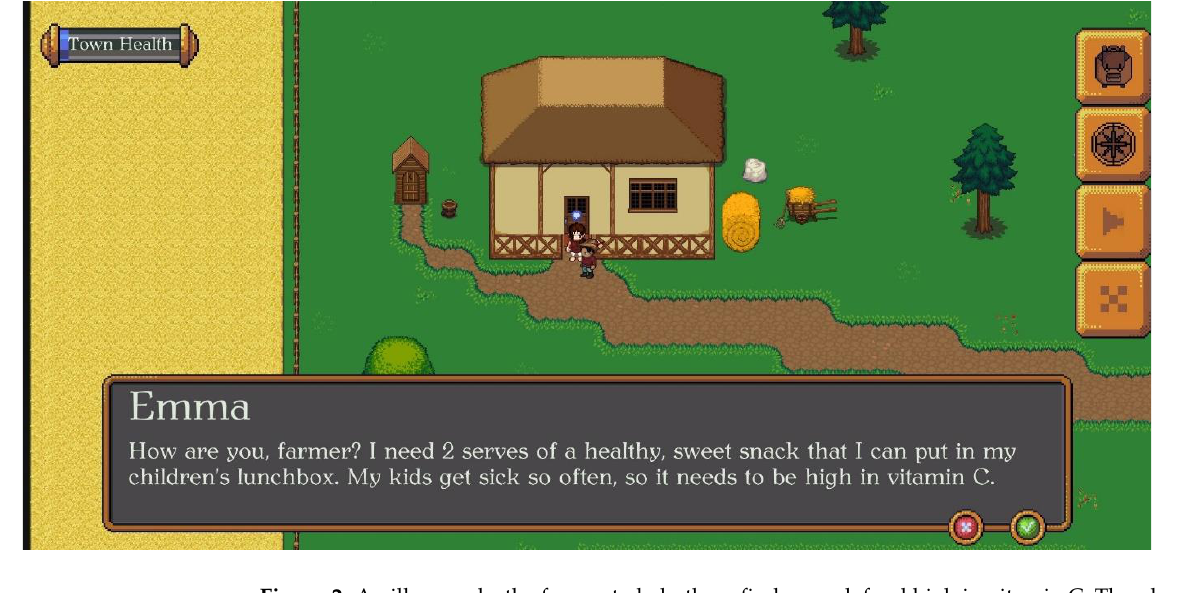
Figure 2. A villager asks the farmer to help them find a snack food high in vitamin C. The player will have to visit the village’s grocery shop. The village shop’s inventory is sorted by vitamins, minerals and dietary fibre. After clicking on a nutrient, a list of associated foods with basic information appears (e.g., Vitamin C lists strawberries, broccoli, potatoes and tomatoes) (see Figure 3).